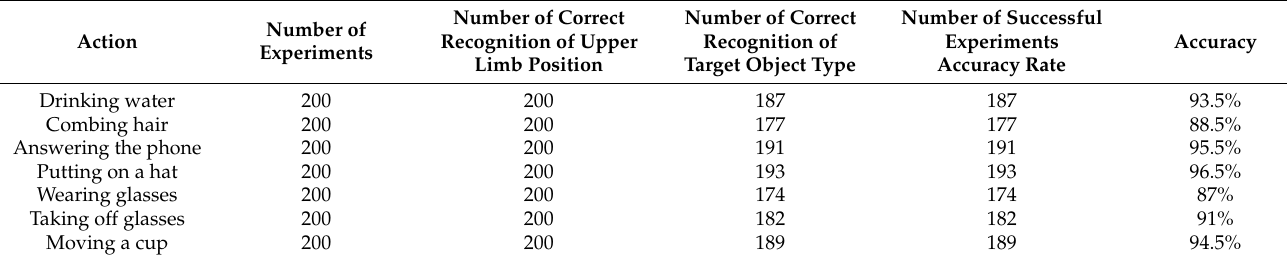
Table 3. Experimental